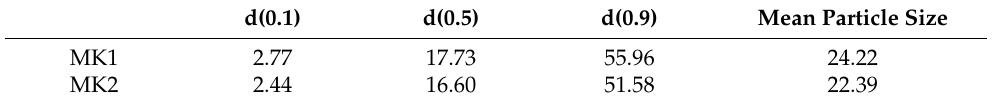
Figure 1. ( a ) Particle size distribution of MK1 and MK2. SEM micrographs of ( b ) MK1 and ( c ) MK2. Dark blue line and red dashed line represents the cummulative percentage (in mass) of both MKs. Table 2. Granulometric parameters (μm) obtained for MK1 and MK2.